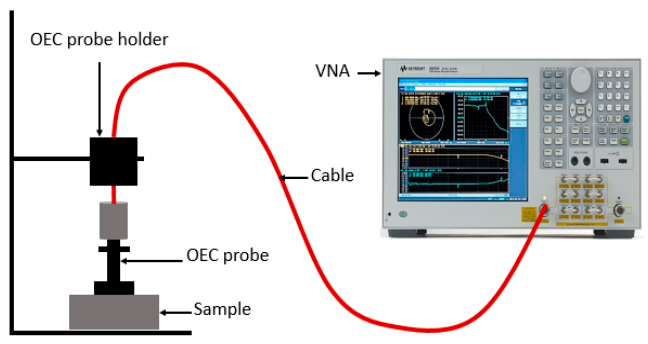
Figure 2. Complex permittivity measurement using open-ended coaxial (OEC).